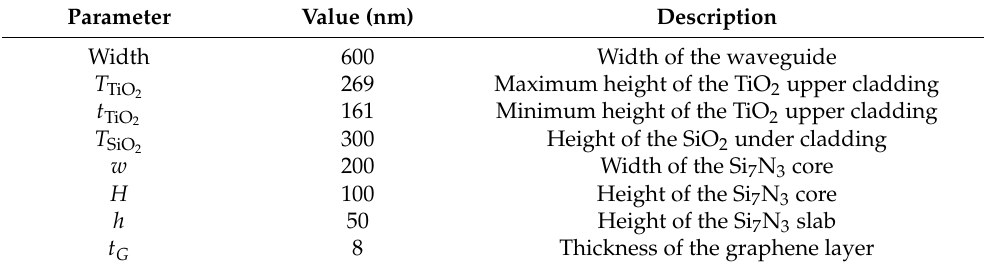
Figure 3. ( Left ): straight waveguide cross-section. ( Right ): mode analysis in a curved waveg- uide. A PML boundary condition is applied on the quadrilateral-meshed region to avoid the influence of reflection. Table 3. Cross-section parameters.